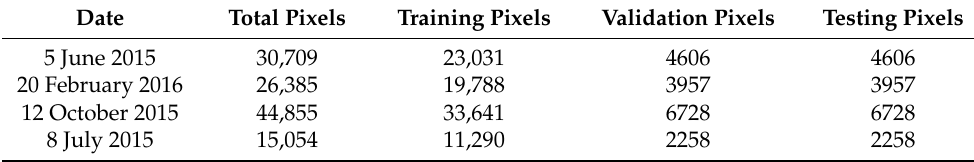
Table 7. Rain rate estimation